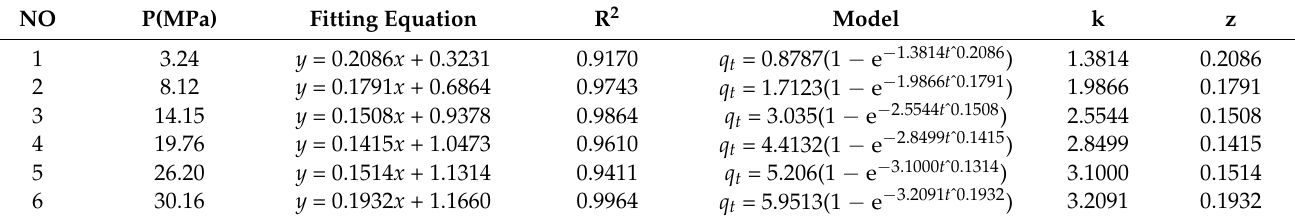
Figure 7. Fitting methane adsorption dynamic using Bangham model at 50 °C. Table 3. The results of fitting methane adsorption dynamic using Bangham model at 50 °C.